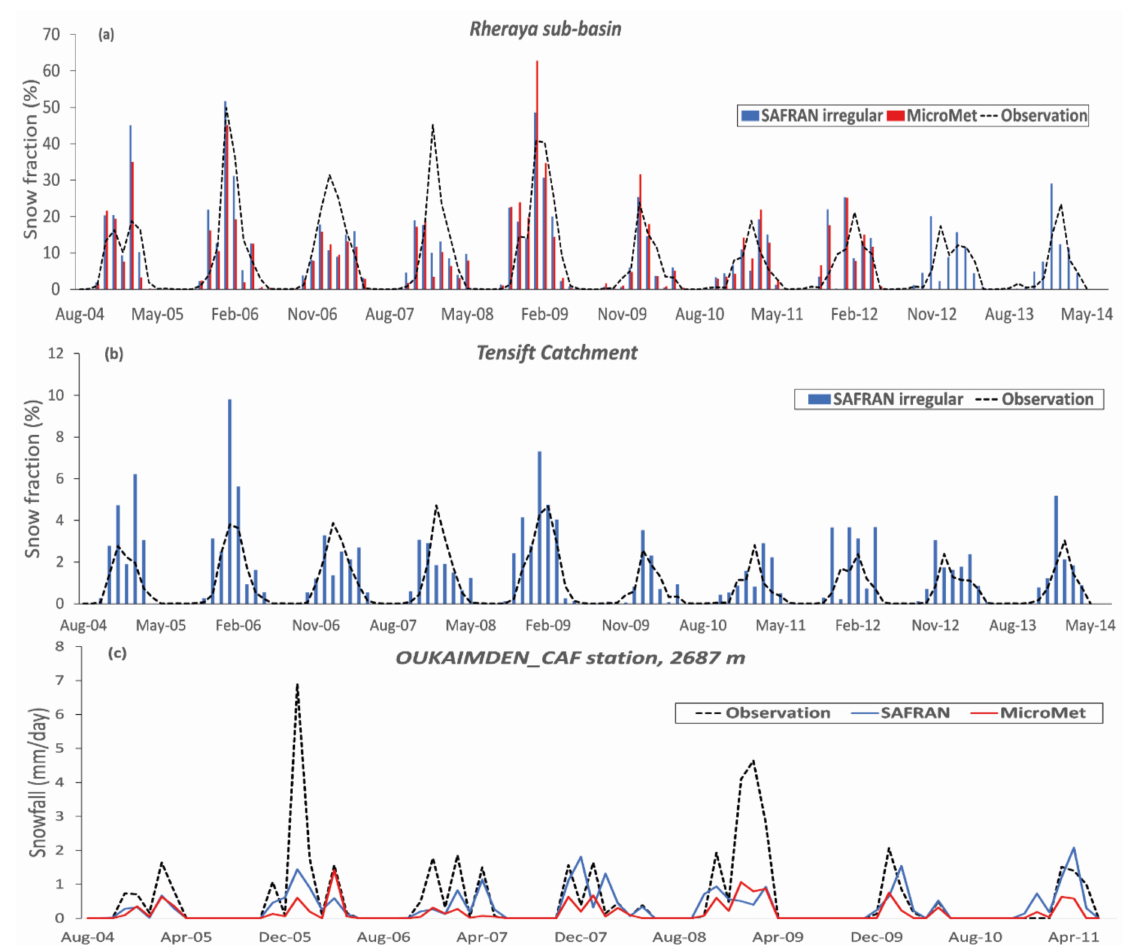
Figure 5. Snow cover fraction for ( a ) the Rheraya sub-basin and ( b ) the Tensift catchment over the period 2004–2014 derived from SAFRAN (irregular grid) and MicroMet and from the daily MODIS products (see text); ( c ) time series of monthly snowfall (mm/day) predicted by SAFRAN (Irregular grid) and MicroMet and observed at the Oukaimden_CAF station for the period